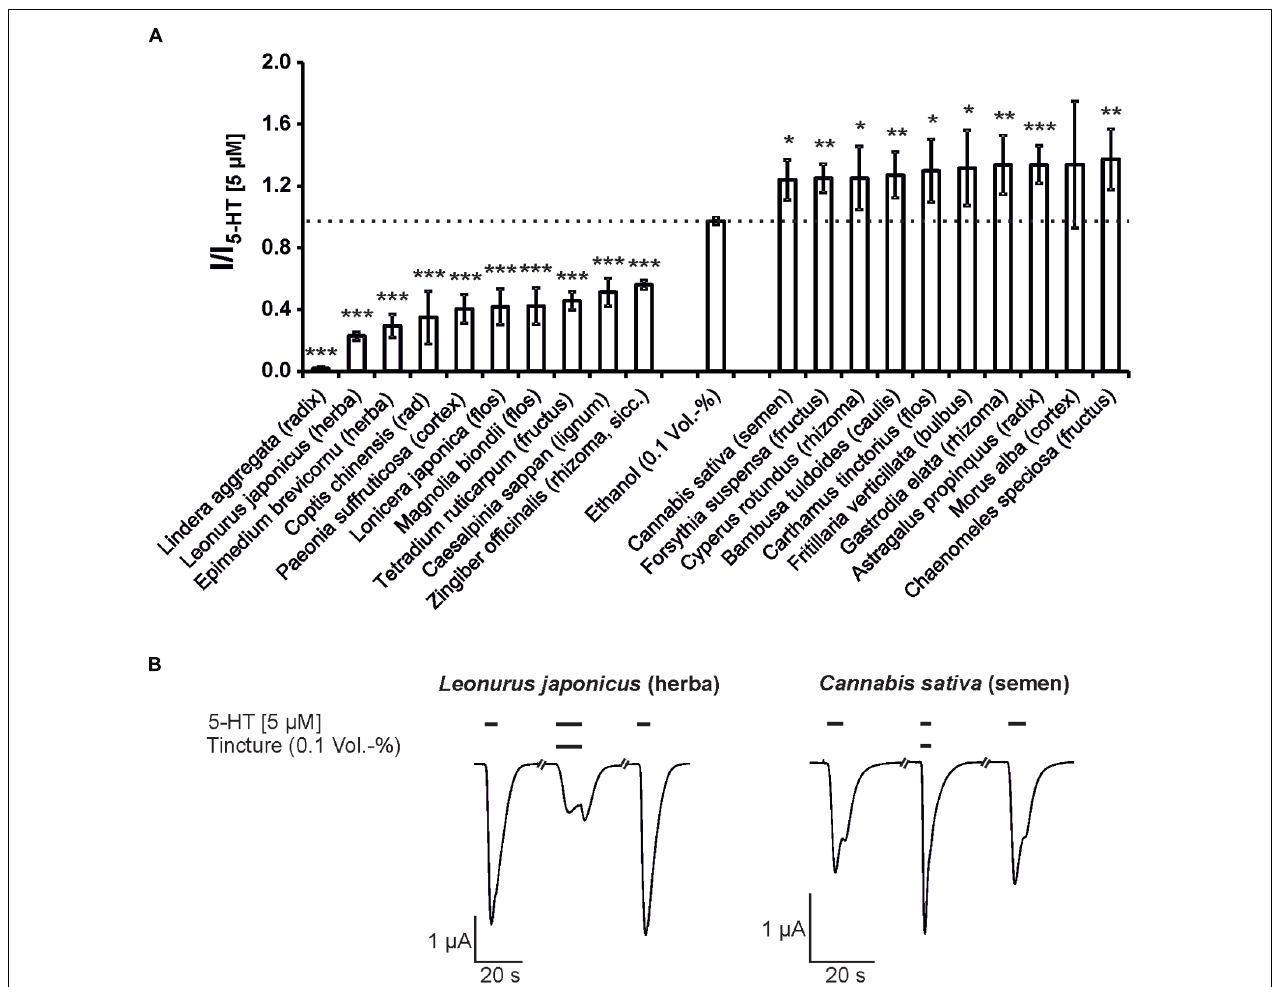
FIGURE 2 | The modulatory action of the strongest inhibitory and potentiating Kampo tinctures on the 5-HT 3A receptor. (A) The tinctures with the 10 strongest antagonistic (left) and potentiating (right) effects are shown (5 µ M 5-HT). Bars exceeding the dotted line represent potentiating effects. Statistical significance was calculated based on the reference solution containing 0.1 Vol.-% ethanol (equal to the max. ethanol concentration in the tinctures; ∗ p < 0.05, ∗∗ p < 0.005, ∗∗∗ p < 0.0005; n = 3–8). (B) Original registrations of the modulation observed by Leonurus japonicus (herba) and Cannabis sativa (semen) using